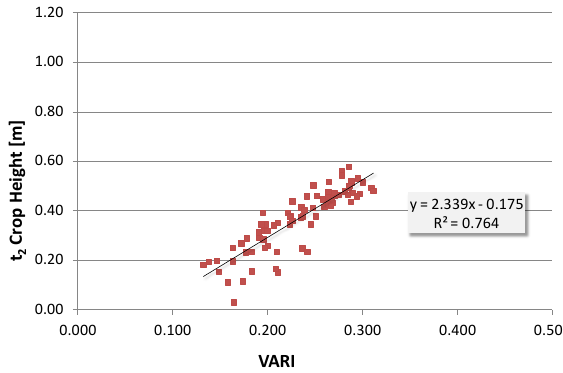
Figure 11. Correlation between vegetation index VARI and crop height for winter wheat trial, measured 24. May 2013 In the third epoch (beginning of July), the correlation between the vigor and plant height is very low, see figure 12. Why ? Because the expectation is a similar correlation as observed in the second period.